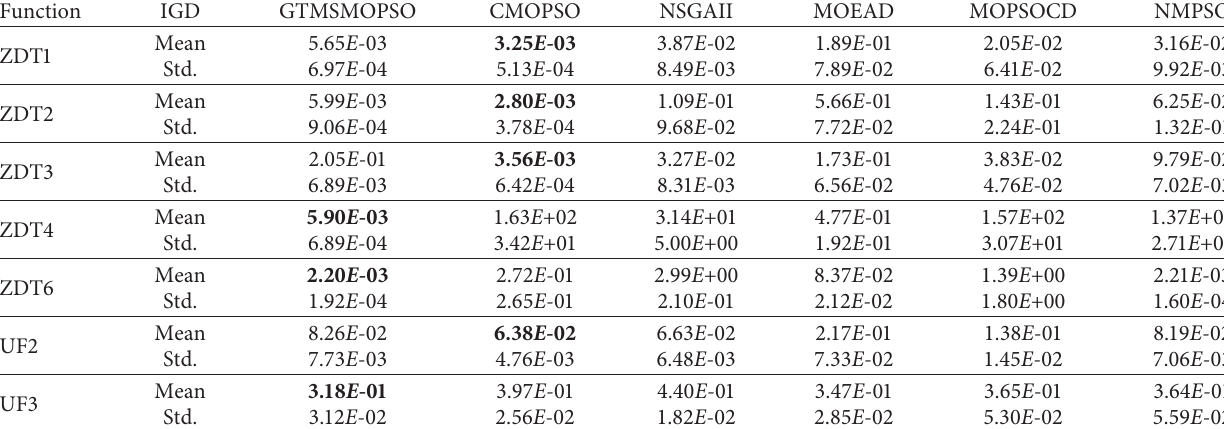
Table 1: The IGD value of the algorithm on 14 test